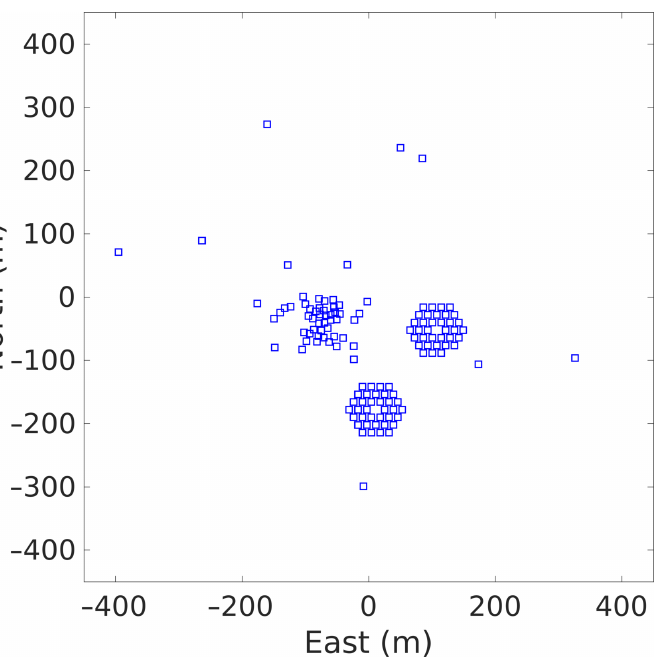
Figure 2. A plan view of the Murchison Widefield Array’s compact configuration of Phase II, showing the location of the 128